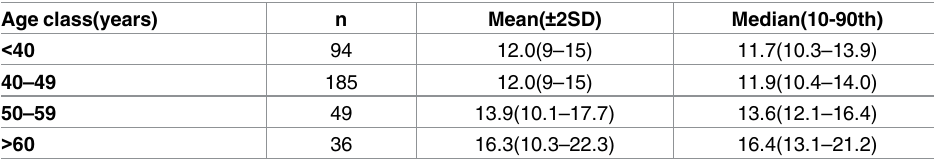
Table 6. Normal values of